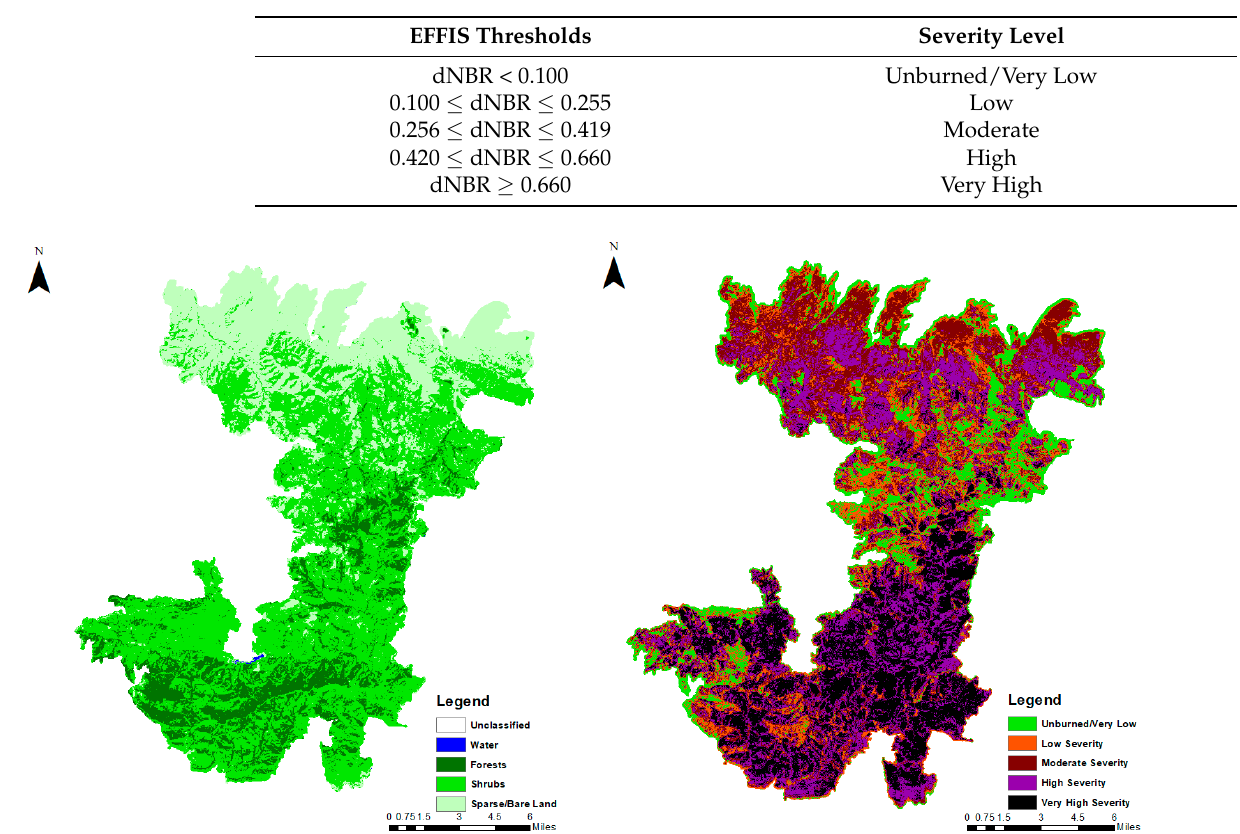
Table 6. Differenced Normalized Burn Ratio (dNBR) thresholds proposed by the European Forest Fire Information Service (EFFIS).